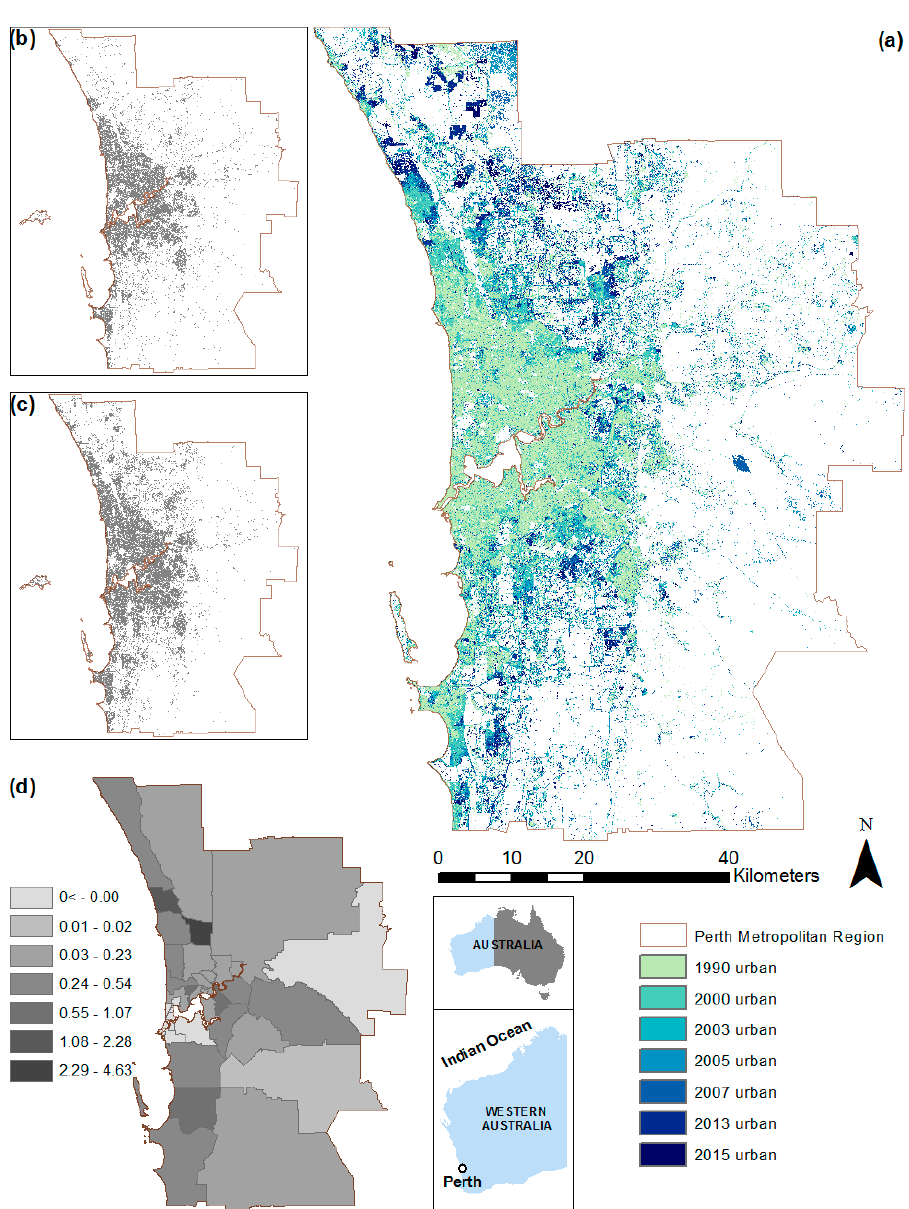
Figure 2. Urban expansion within the Perth Metropolitan Region (PMR) between 1990 and 2015. Vast urban growth has been observed in PMR with graduating colours exhibiting outward expansion ( a ); ( b ) and ( c ) exhibit static snapshots of urban extent from 2000 ( b ) and 2015 ( c ); whilst ( d ) depicts percentage of urban change per subnational administrative boundary (Local Government Area; LGA).